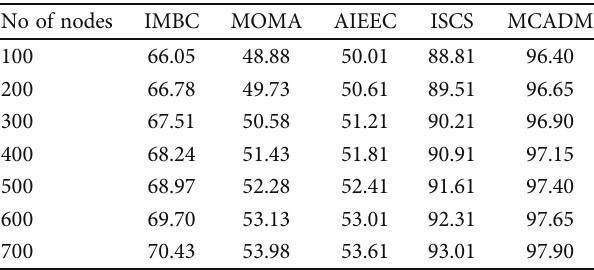
Table 6: Management of perception subsystem. No of